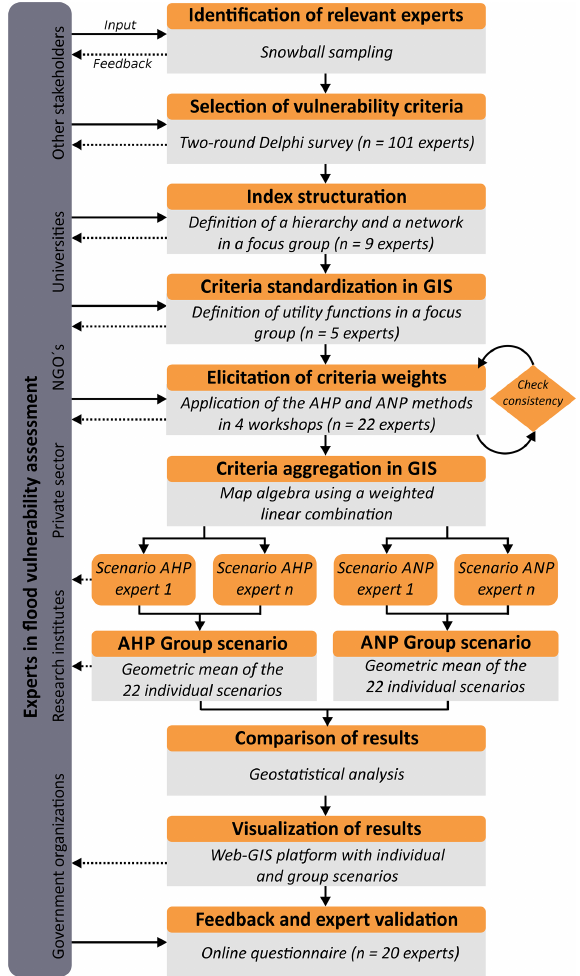
Figure 2. Methodological framework for flood vulnerability assess- ment. The solid horizontal arrows denote the input given by experts while the dashed arrows indicate the feedback provided to them in the form of partial reports. The number of participants in each step of the index development process is shown in parentheses.